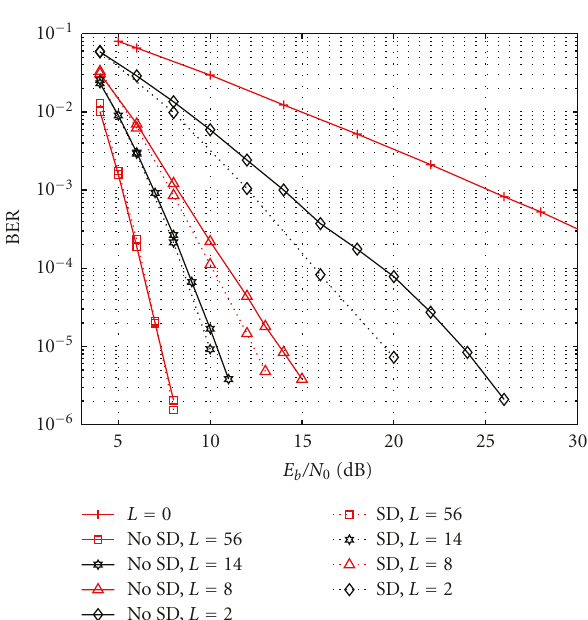
Figure 12: Performance of distributed GLD codes of UPA scheme with and without source-destination path.